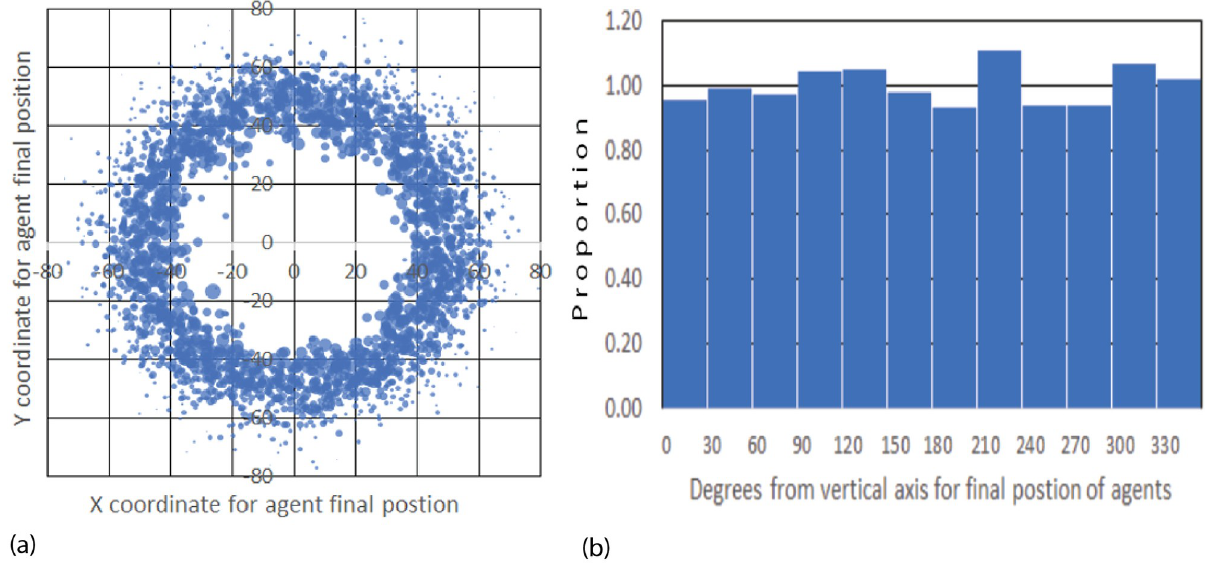
Fig 3. Distribution of Agents at the end of 1000 simulations for AIB = 100, standard conditions: a) Scatter plot of final location. The size of each point correlates with the agent mass; b) Angular distribution in sectors of 30 degrees. 1 means random distribution. The mean for all 12 sectors is 1.00 (random) and the SD